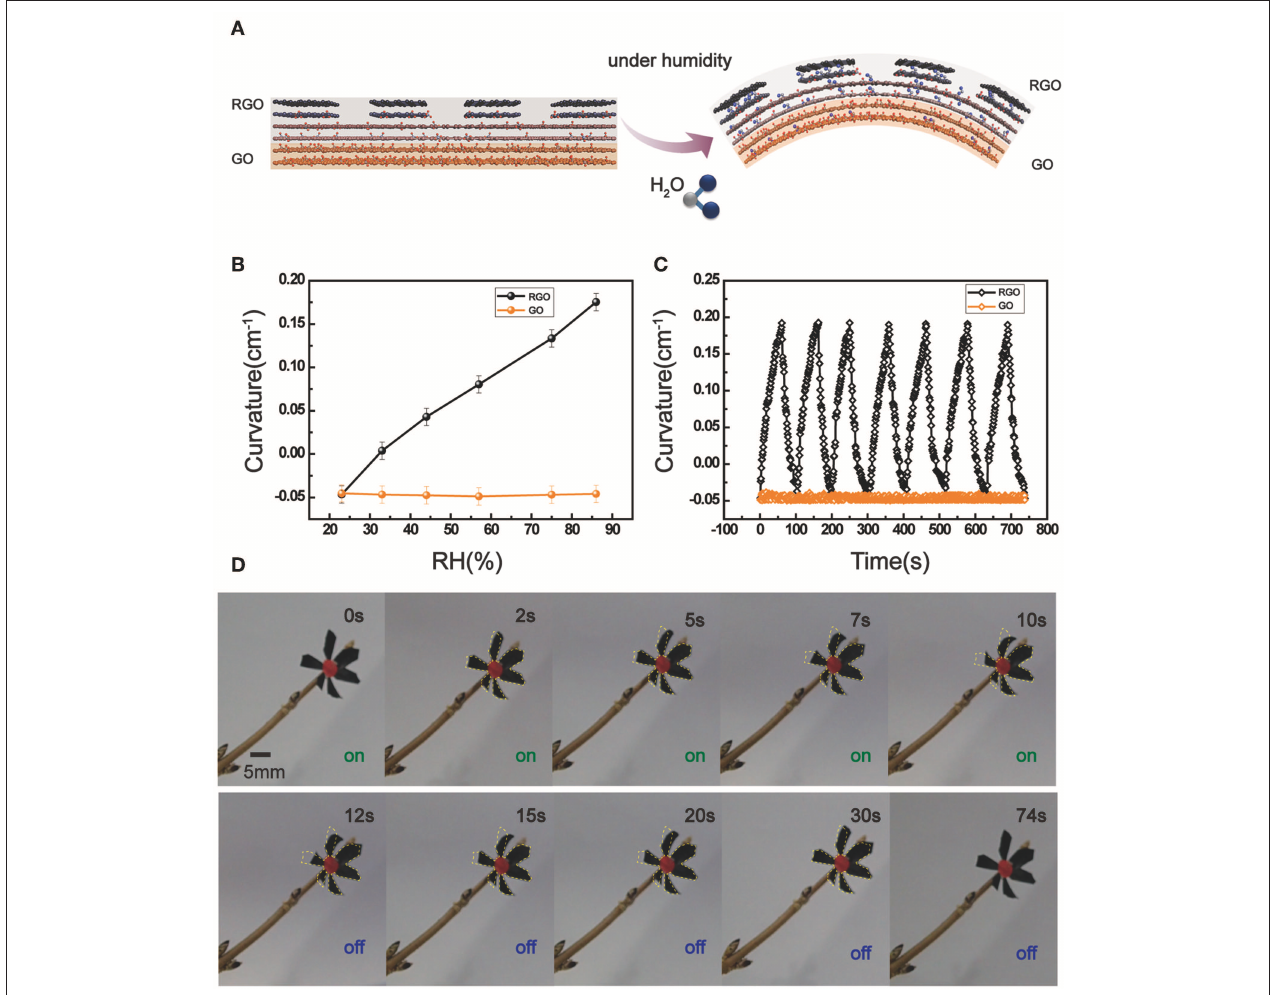
FIGURE 4 | (A) Schematic illustration of the bending behavior of the GO/RGO bilayer structure. Water molecules have been demonstrated in blue color in GO/RGO structure for easy to identify. (B) Bending curvature for GO paper and GO/RGO bilayer structures. (C) Reversible moisture response of GO and GO/RGO. (D) The moisture-responsive flower robot made of GO/RGO